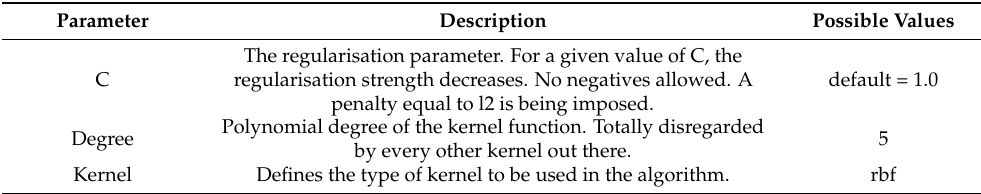
Figure 12. Performance of ACO ‐ SVM on Heart Disease . The selected best SVM parameters are shown in Table 3. Table 3. Selected best ACO ‐ SVM parameters.